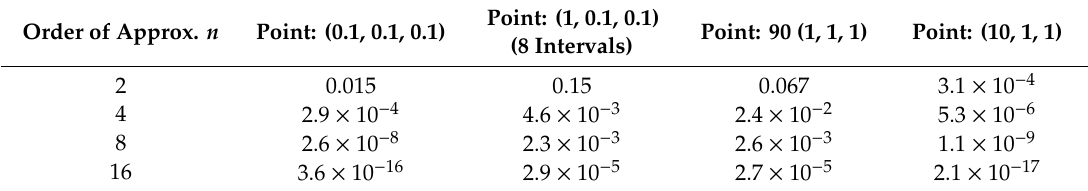
Table 9. Magnitude of relative error in evaluation of E X ( x , y , z ) using four sub-intervals and eight sub-intervals for the point (1, 0.1,